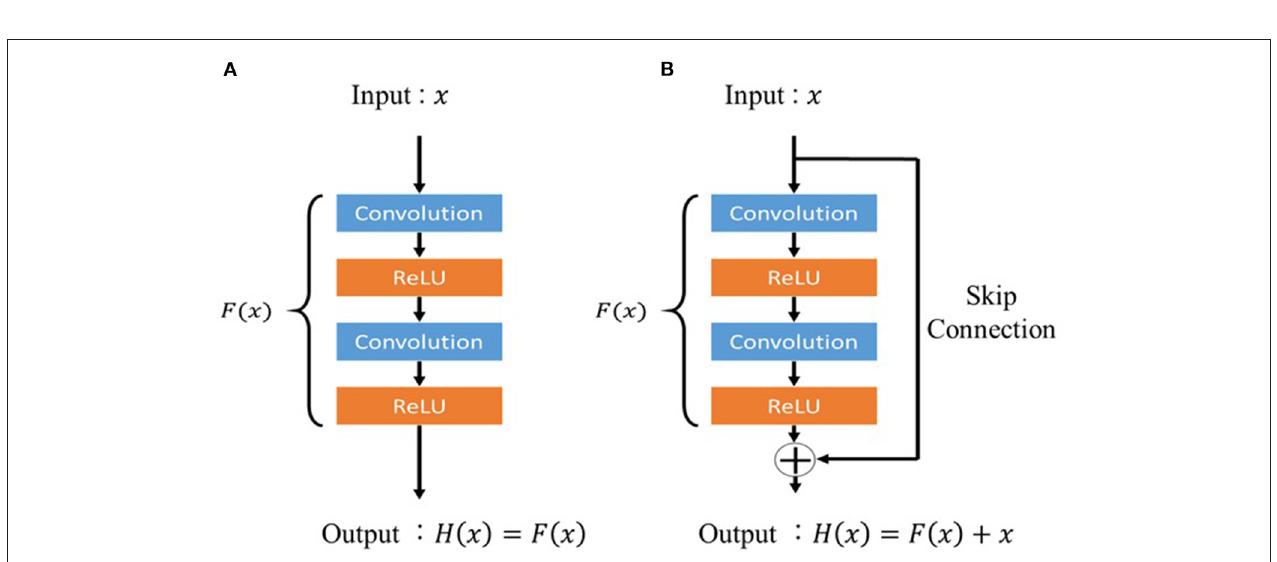
FIGURE 2 | Architecture of the residual unit. (A) Conventional feed-forward neural network and (B) residual unit.